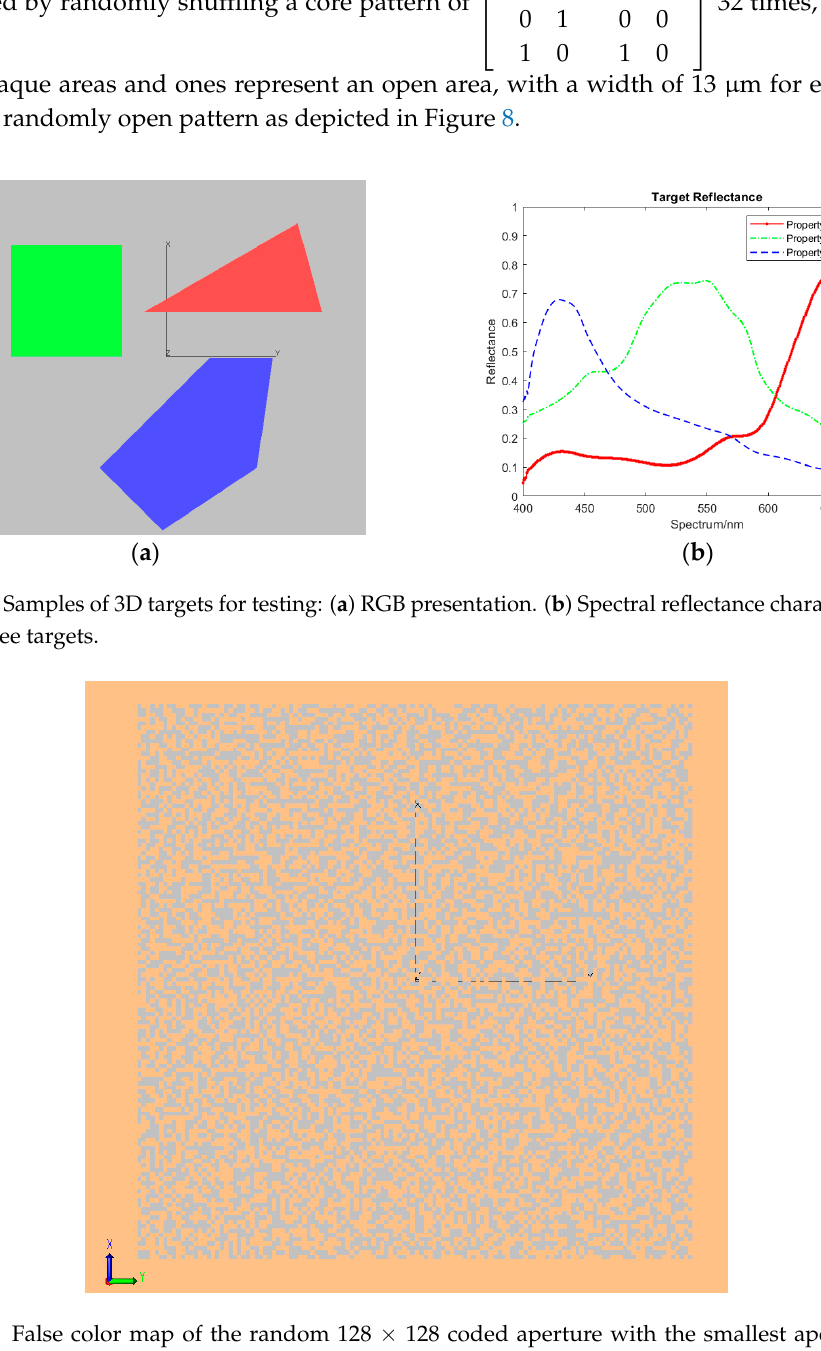
Figure 8. False color map of the random 128 × 128 coded aperture with the smallest aperture of 13 μ m. The mask was constructed using the “perfect absorber” property with geometric sizes of 1.664 × 1.664 mm.